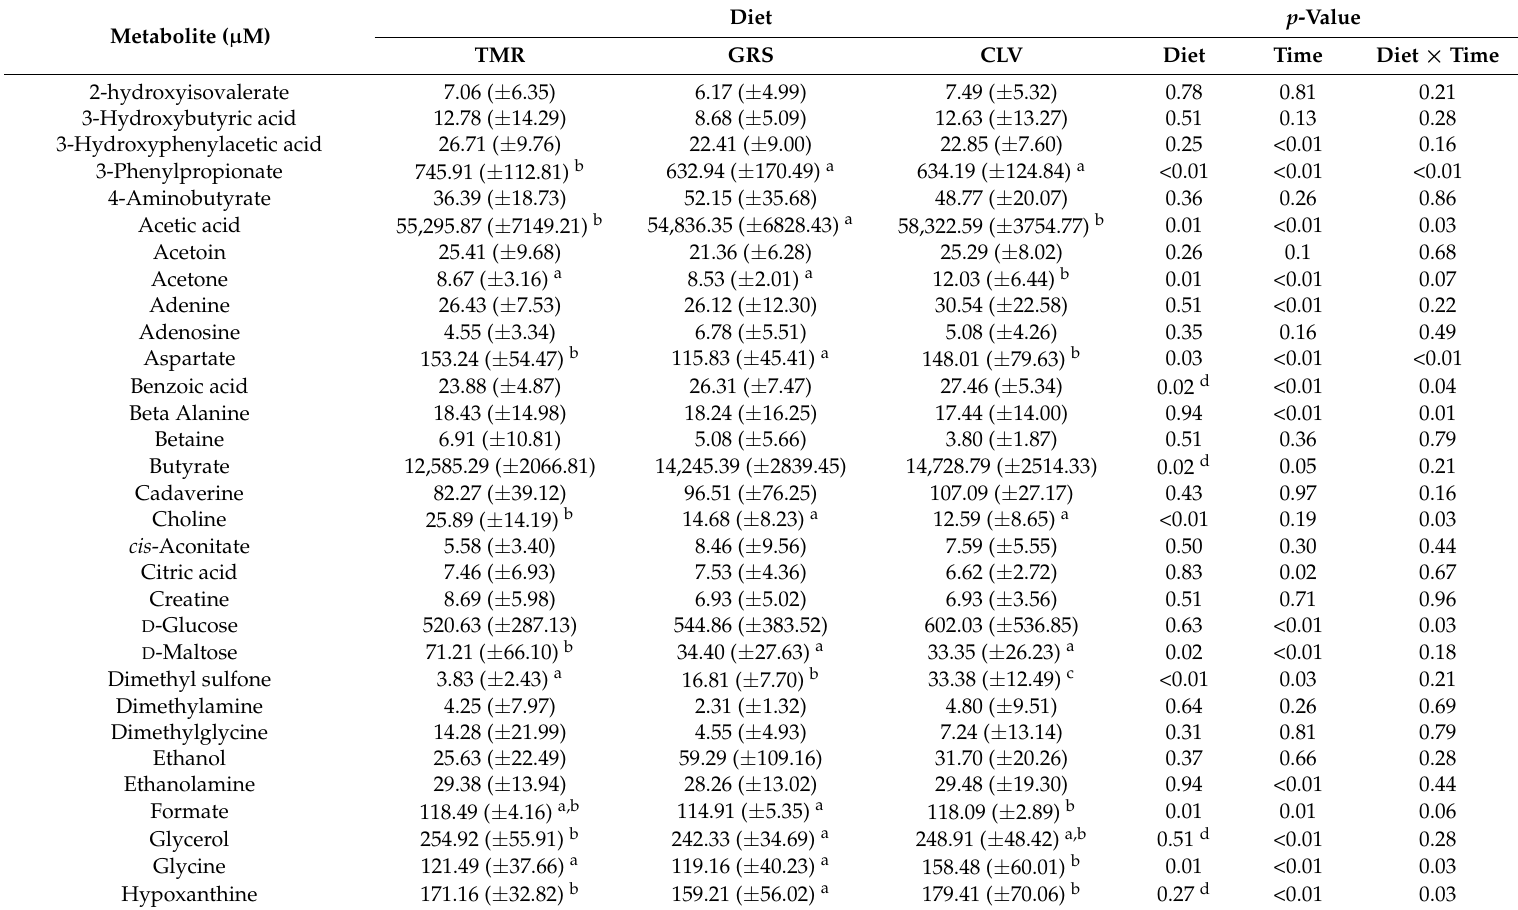
Table 1. Average concentrations (Mean ± standard deviation) of rumen metabolites ( µ M) measured in the rumen of lactating dairy cows fed diets consisting of total mixed ration (TMR), perennial ryegrass (GRS), or perennial ryegrass and white clover (CLV), as determined by 1 H-NMR. Adjusted p -values from the ANOVA test for the feed system, lactation period, and their